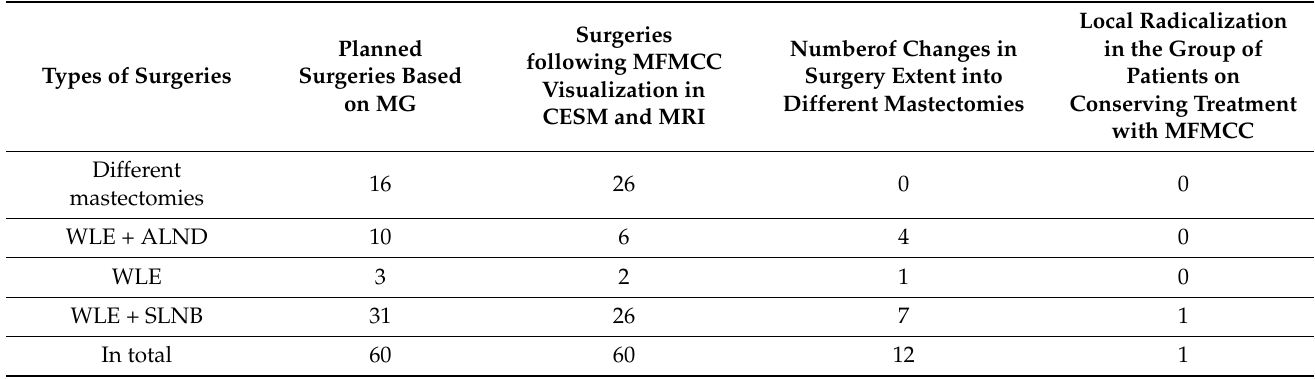
Table 3. Changes in surgery extent upon identification of MFMCC in CESM and